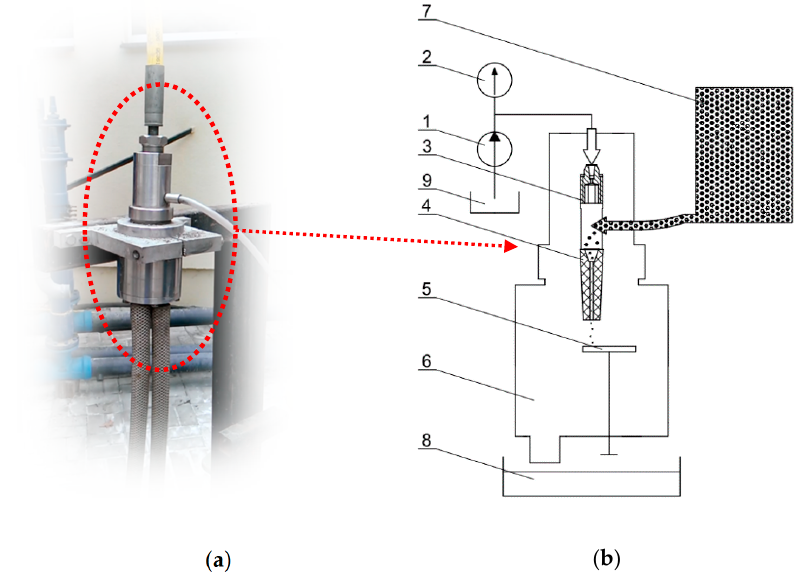
Figure 1. General view of experimental setup ( a ), and a diagram of a hydro-jet mill ( b ): 1—high-pressure pump, 2—manometer, 3—water nozzle, 4—comminuting nozzle, 5—comminuting disk, 6—shredding chamber, 7—feed tank, 8—product tank, 9—water tank.